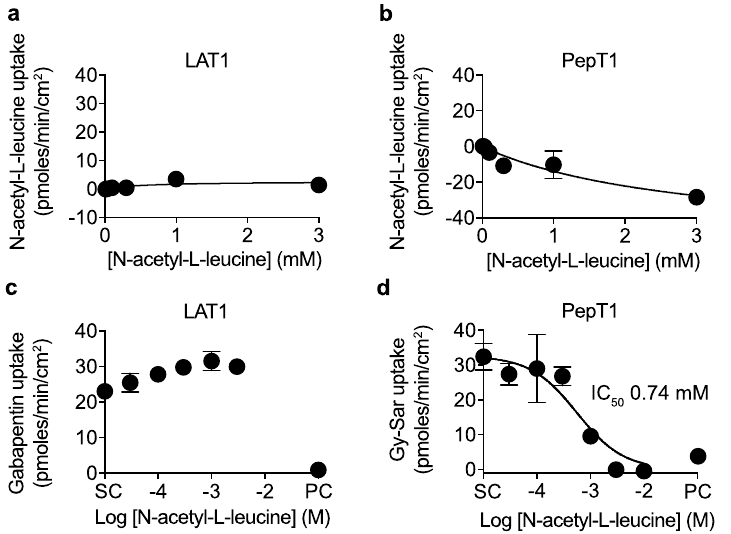
Figure 2. N -acetyl-l-leucine is not transported by either the l-type amino acid transporter (LAT1) nor the peptide transporter (PepT1). Concentration–response curves for the uptake of N -acetyl-l-leucine by ( a ) LAT1 and ( b ) PepT1. Concentration-inhibition curves for the inhibition of uptake of known substrates ( c ) gabapentin (10 µM) for LAT1 and ( d ) dipeptide Gly-Sar (50 µM) for PepT1. DMSO (0.5%) was the solvent control (SC) and the known inhibitor for the positive control (PC) was JPH203 (10 µM) for LAT1 and losartan (200 µM) for PepT1. Data were fit to either the Michaelis–Menten equation for uptake or the Hill equation for inhibition using the solvent control to define the top and the positive control inhibitor to define the bottom. Symbols represent the mean ± SEM, n = 3. When the error bars are smaller than the symbol, they are not